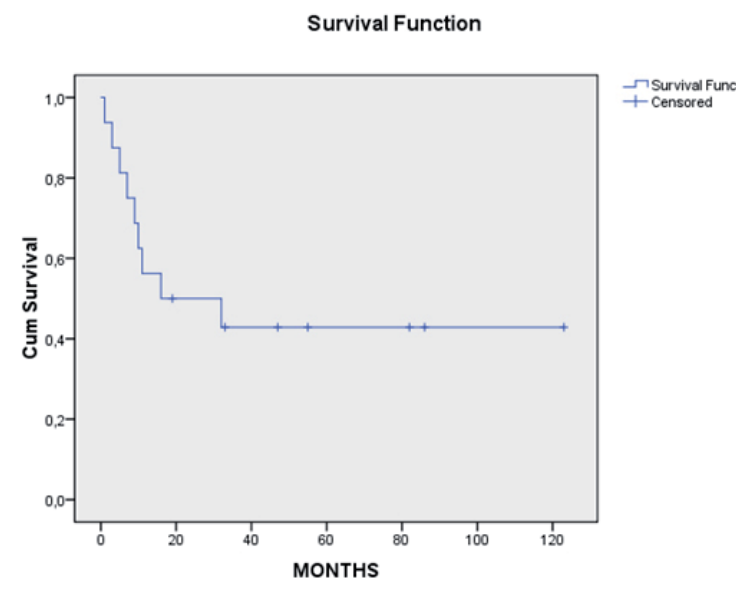
Figure 2 - Kaplan-Meier survival curve of 16 patients submitted to emasculation. Data expressed as percentage of live patients over time. Median overall survival was 16